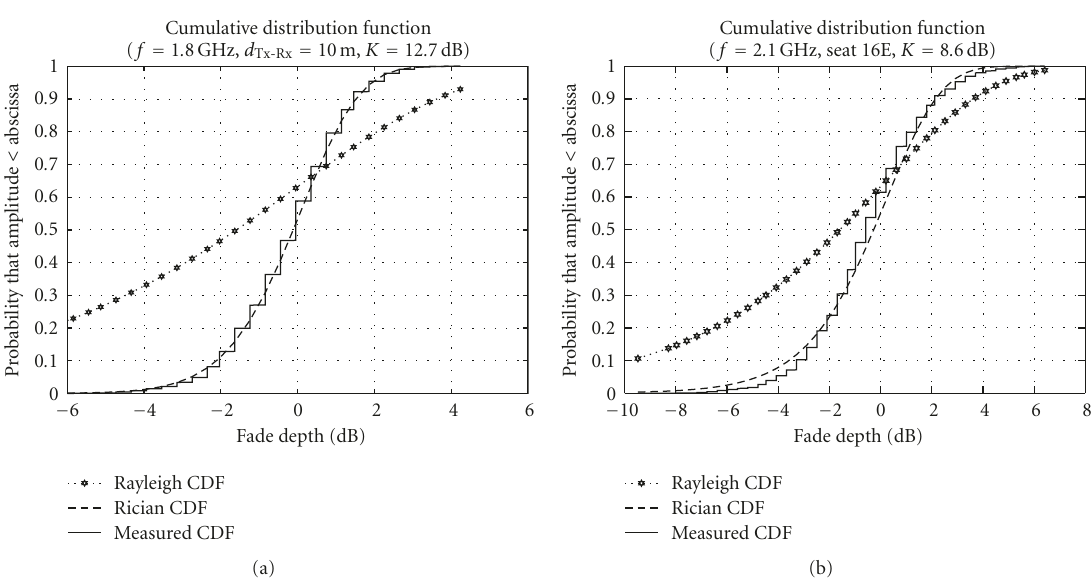
Figure 8: Indicative cumulative distribution functions: (a) at the corridor of the aircraft, and (b) at the seats of the aircraft.